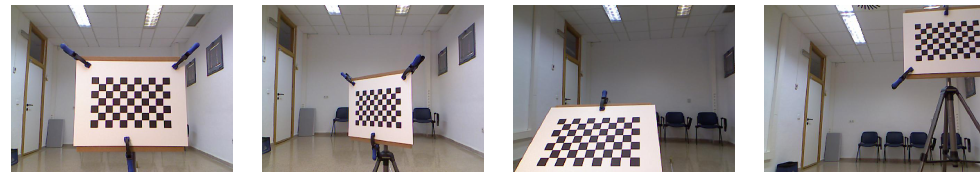
Figure 8. Some images of the chessboard used in the calibration process of Microsoft